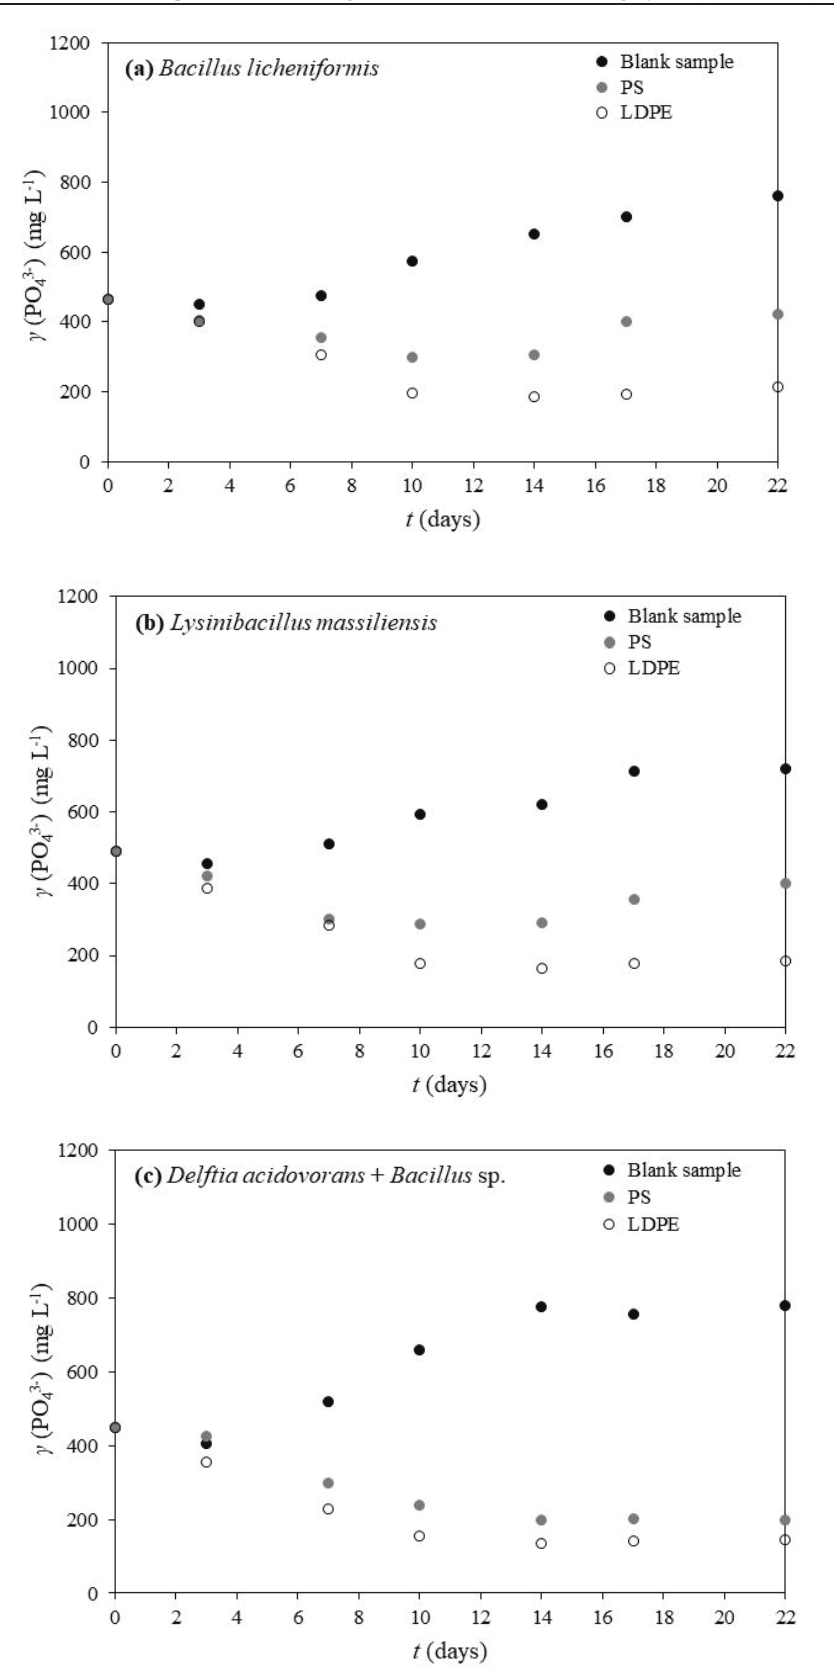
Fig. 8 – Changes in phosphate concentration during biodegradation of MP-LDPE and MP-PS with bacterial culture Bacillus li- cheniformis (a), Lysinibacillus massiliensis (b), and mixed bacterial culture of Bacillus sp. and Delftia acidovorans (c) in sterile Erlenmeyer flasks during 22 days (Vr = 100